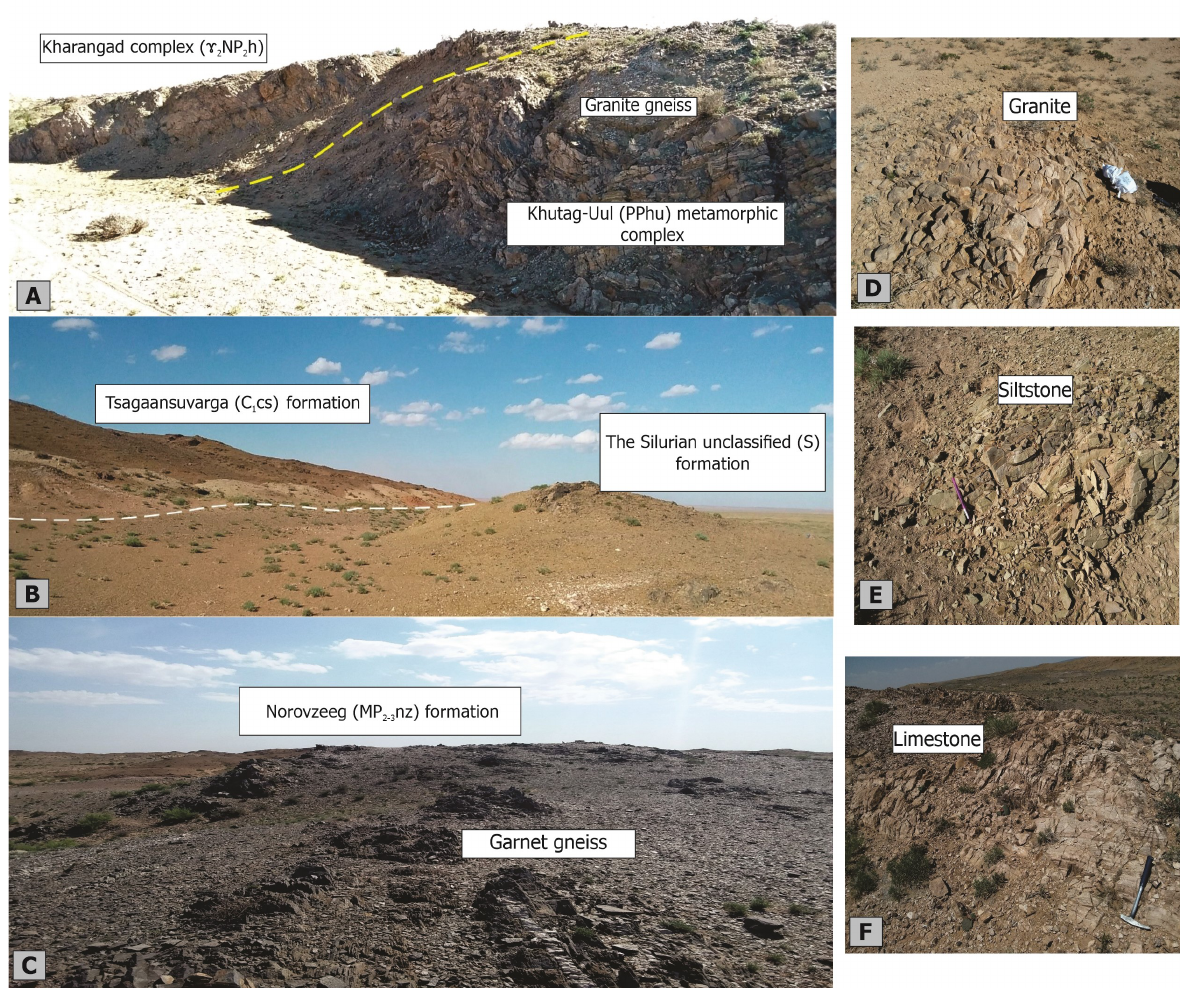
Fig. 3. The field photographs of the study area during fieldwork. (A) The contact between granite gneiss from Paleoproterozoic Khutag-Uul metamorphic complex and granite massif from Kharangad complex; (B) The contact between Tsagaansuvarga formation and siltstone of the Silurian unclassified formation; (C) Garnet gneiss of the Norovzeeg formation; (D) Granite sample SM26-7; (E) Siltstone sample SM26-2; (F) Limestone of the Khutag-Uul formation, sample